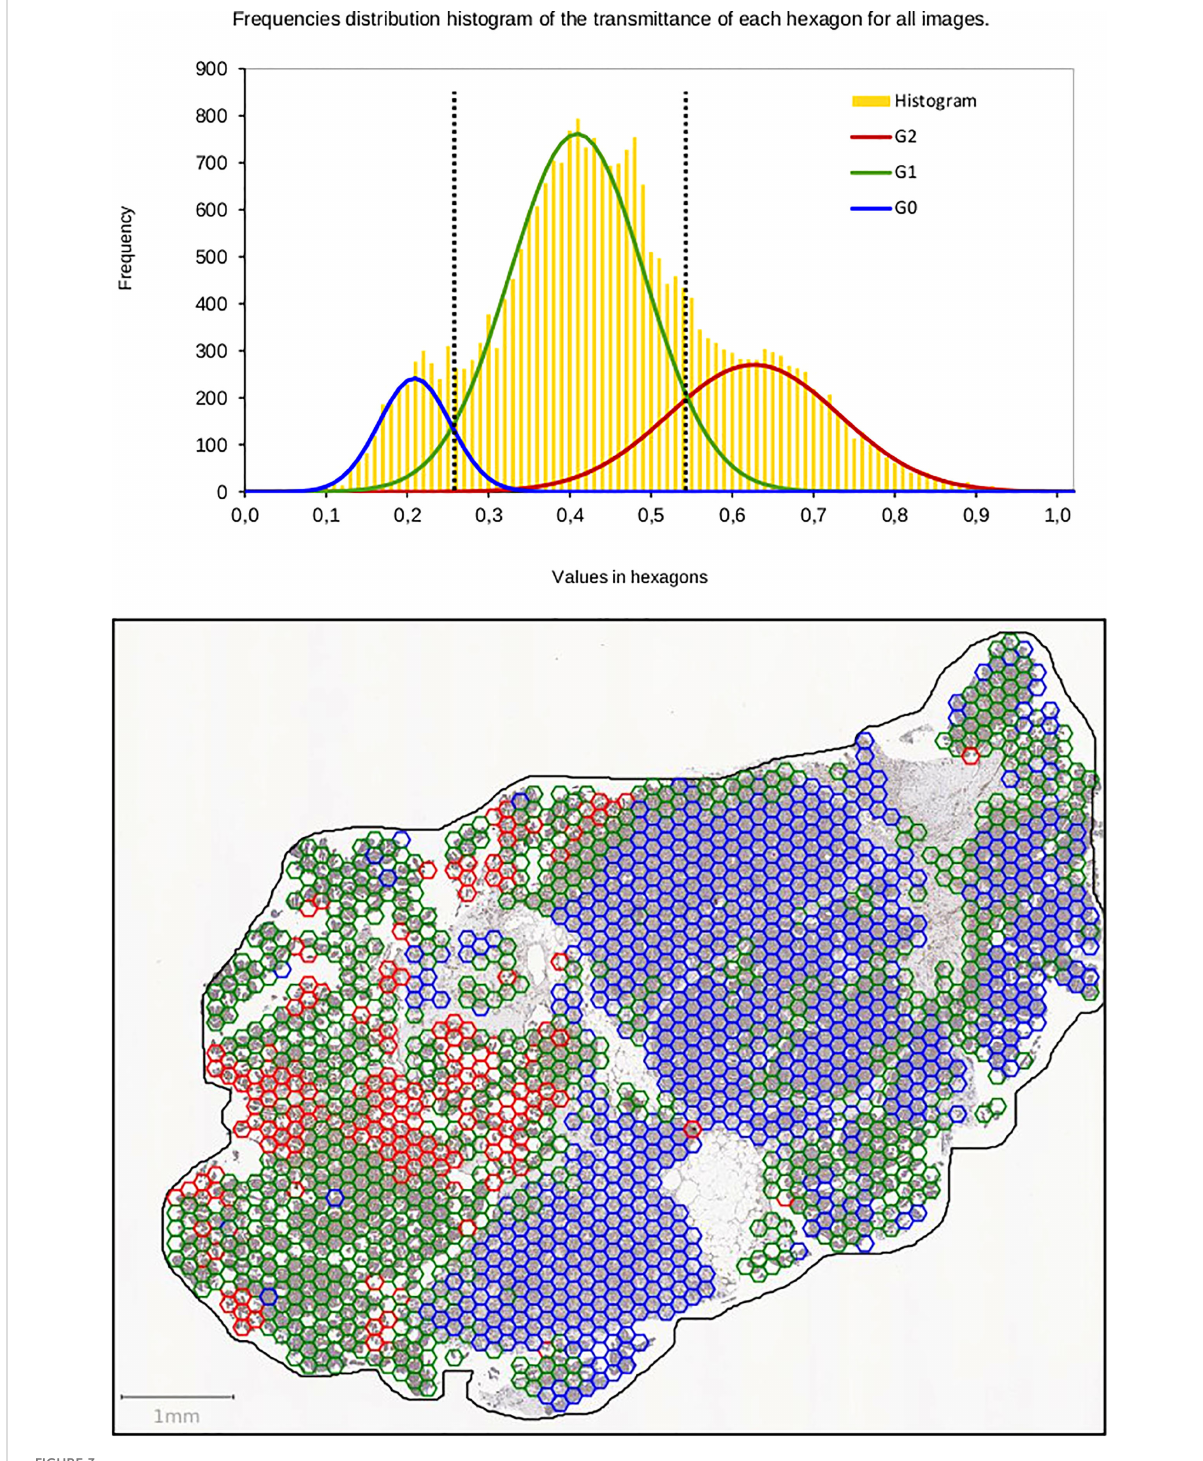
FIGURE 3 Automatic thresholds are determined by the algorithm of the Gaussian Mixture Model on distribution of frequencies of the transmittance for each marker. The threshold values correspond to crossing between Gaussians (dotted lines). The thresholds are used to classify hexagons as low, medium, and high intensity (hexagons blue, green,